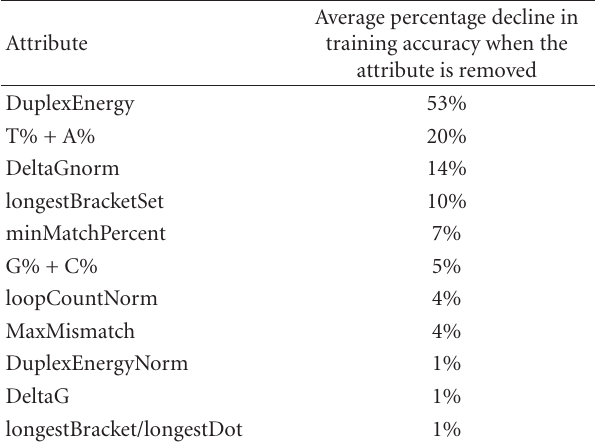
Table 6: Attributes with an average decline of 1% or greater when